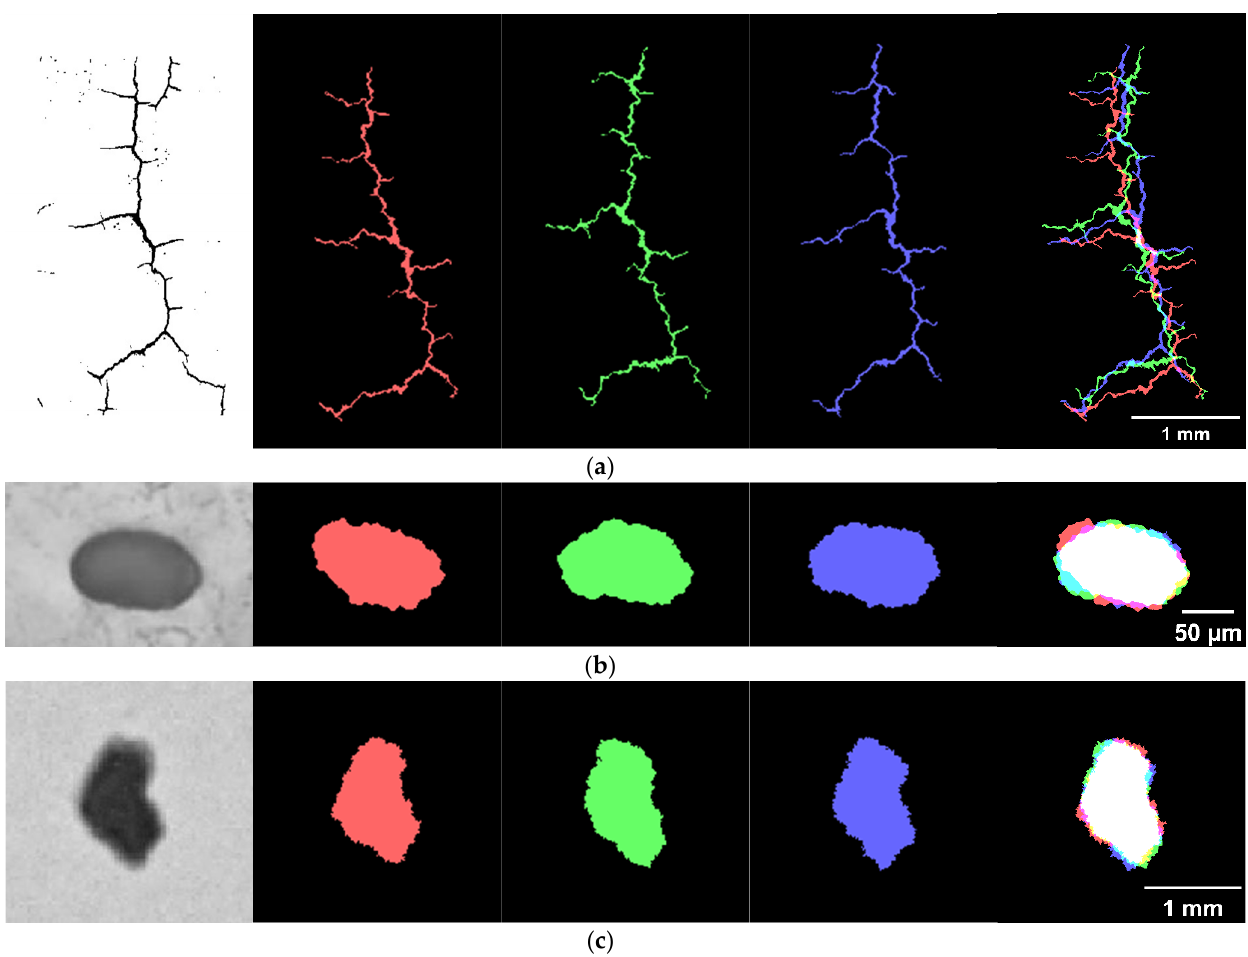
Figure 3. Distorted image: ( a ) a crack; ( b ) a pore; ( c ) an inclusion. The similarities and differences between three typical repetitions are highlighted using pseudo-color imaging, where the shared areas are in white.